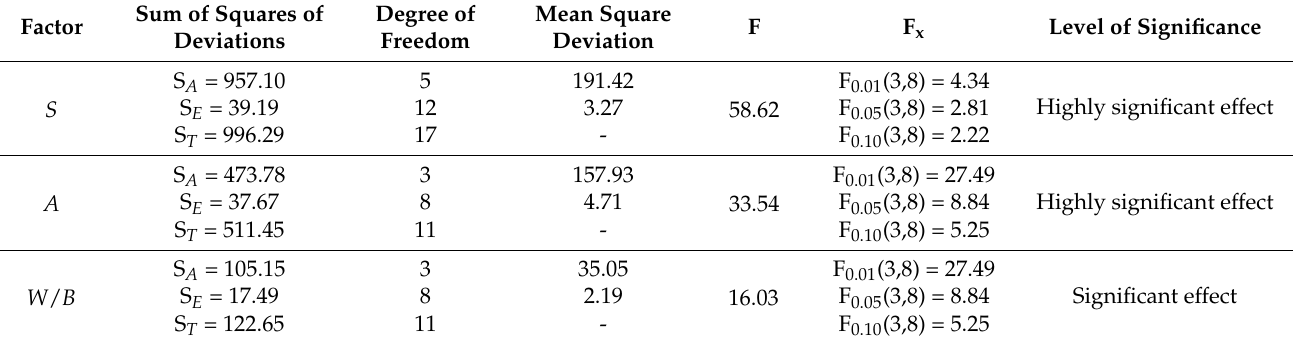
Table 5. Variance analysis of the compressive strength.